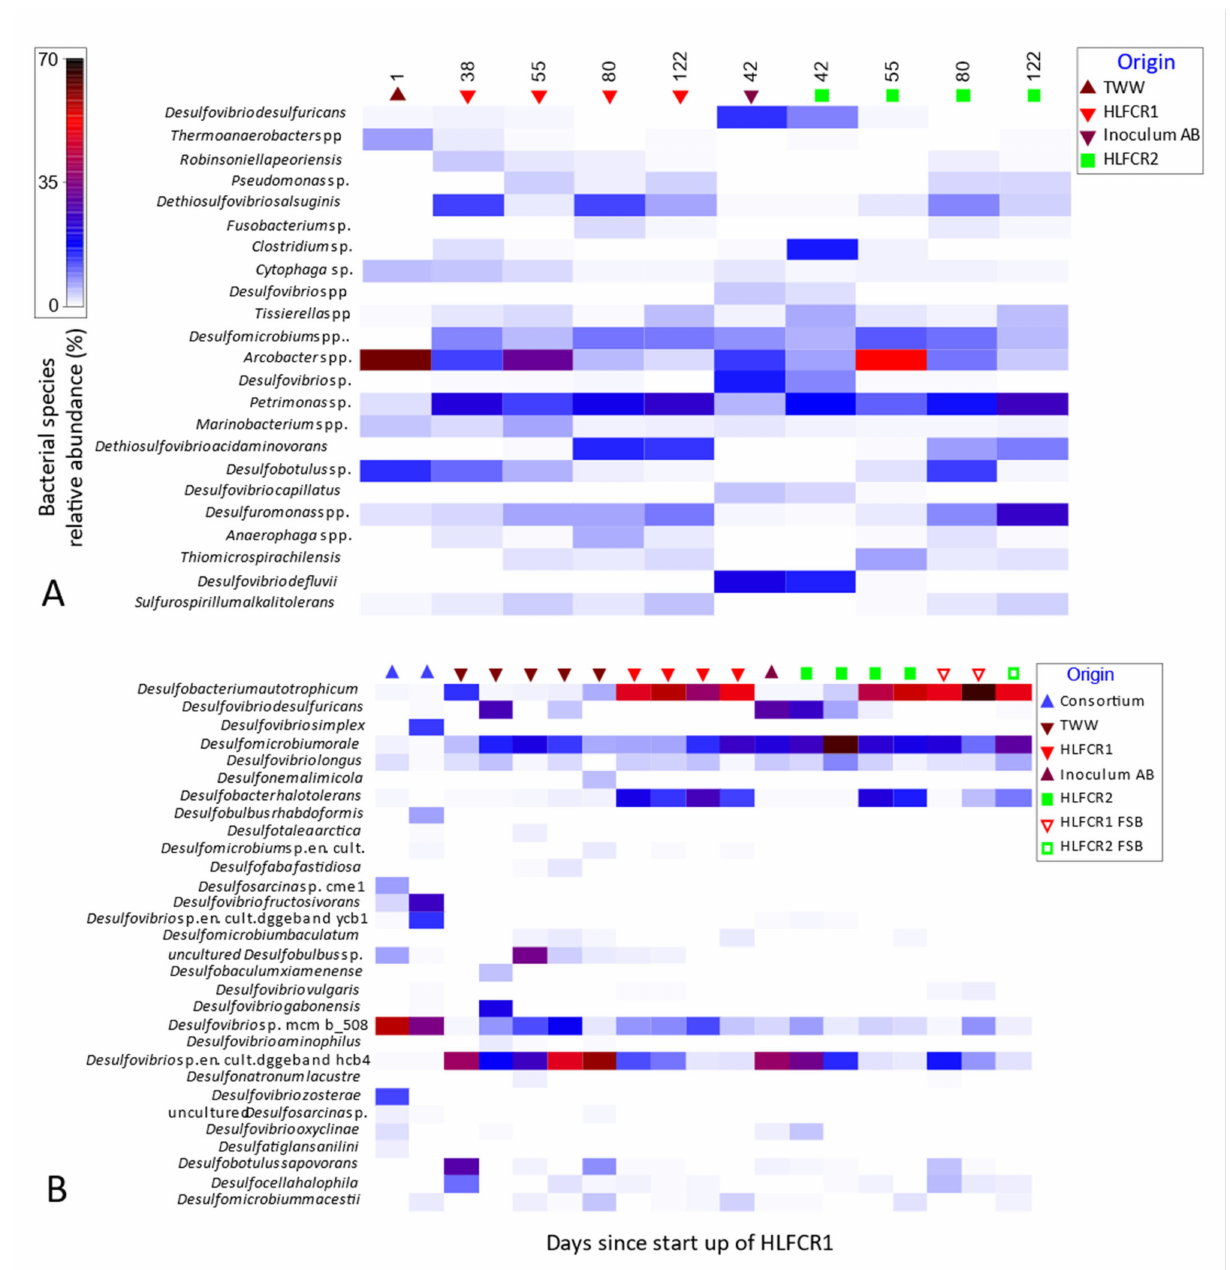
Figure 8. Shadeplot of the most abundant bacterial ( A ) and sulfite reducing ( B ) bacterial species determined using 16S rRNA gene and dsrB primer sets,